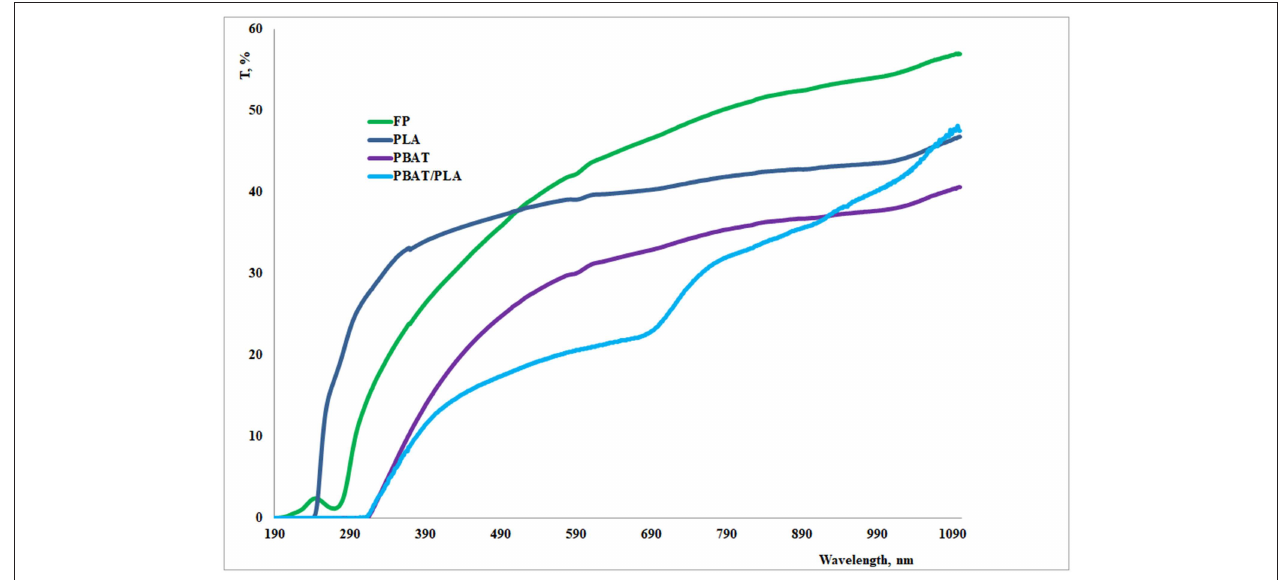
FIGURE 9 | UV spectra of the pristine samples.